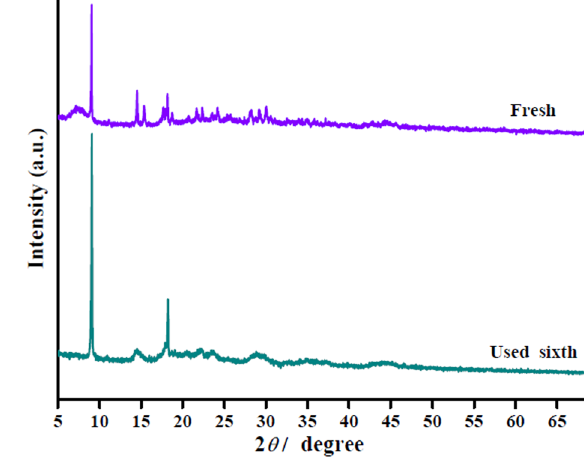
Figure A2: XRD patterns of fresh and used Ce - BDC@HSiW@UiO - 66